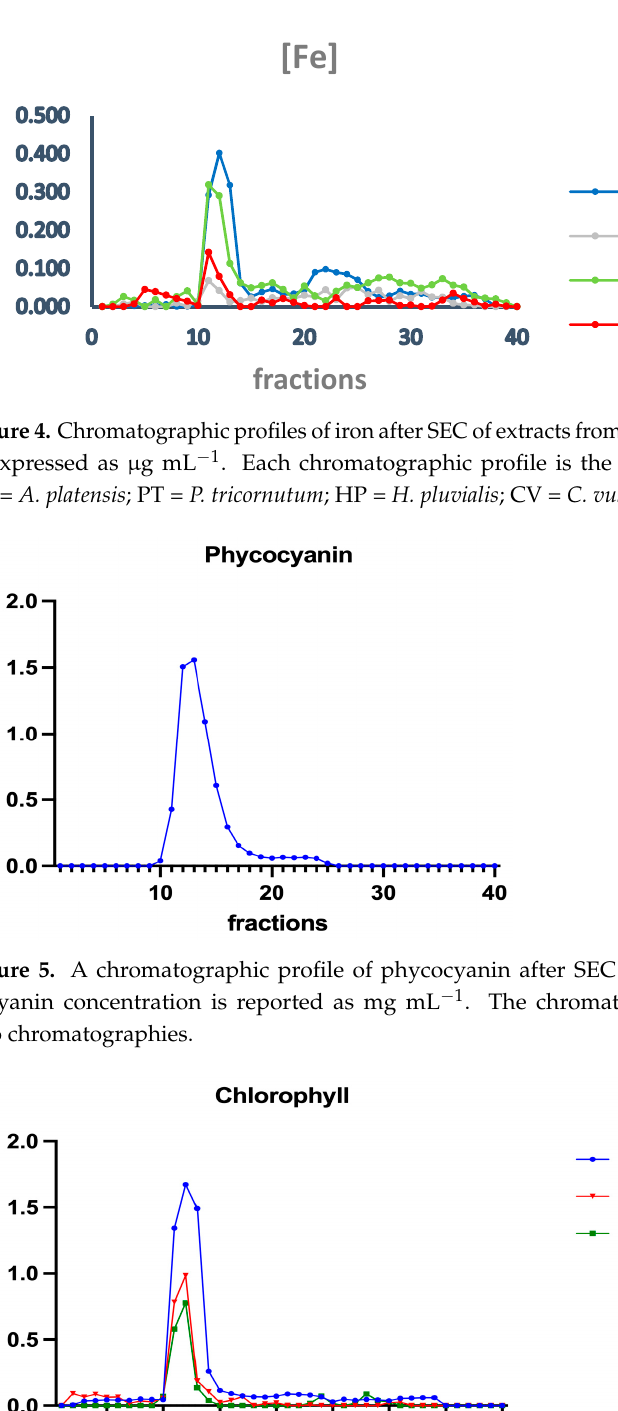
7 of 11 Figure 3. Chromatographic profiles of total proteins after SEC of extracts from algal samples. Pro- teins were detected at 280 nm. Each chromatographic profile is the mean of two chromatographies. AP = A. platensis; PT = P. tricornutum; HP = H. pluvialis; CV= C. vulgaris. In all the samples analysed, a major protein peak was eluted between fractions 11 and 15 (Figure 3). This peak contains proteins with a high molecular mass (HMM), rang- ing from >75 to 40 kDa. A. platensis showed a higher content of soluble proteins than the other microalgae in accordance with its high digestibility. A second peak of absorbance is present between fractions 29 and 34. Small peptides, amino acids and, finally, free ions (starting from fraction 32) elute in these chromatographic fractions. In A. platensis , it has been hypothesised that mycosporine-like amino acids (MAAs) may be present among these low molecular mass molecules [28]. The presence of a second peak is also detectable in C. vulgaris , H. pluvialis, and P. tricornutum , suggesting the presence of small peptides and free amino acids in these species too. Accordingly, Ba et al. (2016) [37] reported the presence of low molecular mass proteins (<10 kDa) in H. pluvialis in the vegetative phase after SEC protein separation. In all the samples analysed, the elution profile of iron after SEC presented a major peak between fractions 11 and 14 (Figure 4), overlapping the main peak of proteins at HMM (Figure 3), indicating that the most relevant metal burden is bound to proteins. A.